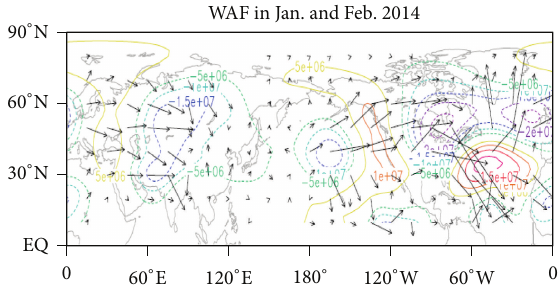
Figure 4: Rossby Wave Activity Flux in January and February